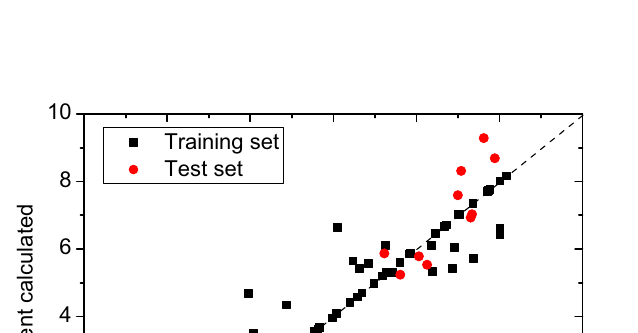
Table 4. Comparison of model statistics in MLR and SVM models.